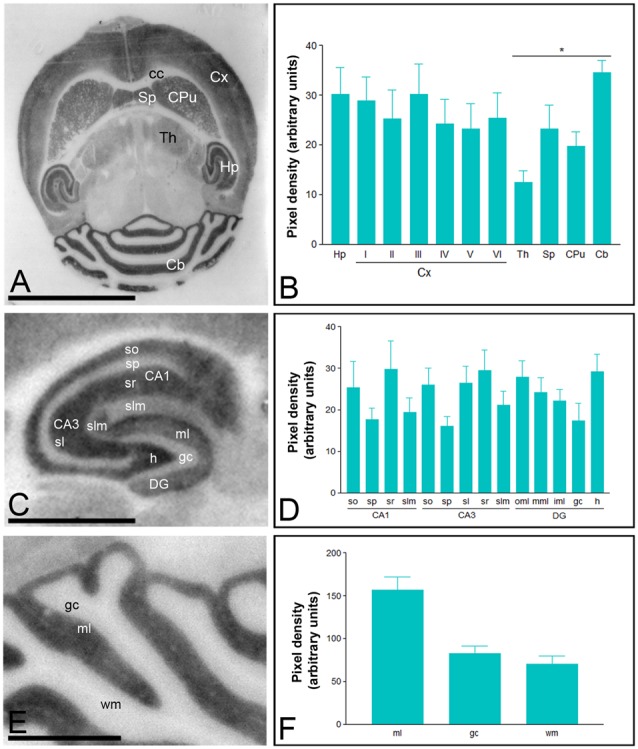
Regional distribution of the T-type Ca2+ channel Cav3.2 subtype in the adult mouse brain. Protein distribution was visualized on histoblots of brain horizontal sections at P90 using affinity-purified anti-Cav3.2 antibodies. The developed histoblots were scanned and densitometric measurements from five independent experiments were averaged together to compare the protein densities. (A,B) The strongest expression was detected in the Cb, Hp, Sp, Cx and CPu, with weaker expression in the Th and no expression in the corpus callosum (cc). In the Cx, the strongest expression levels were found in layer III. (C,D) In the Hp, very strong Cav3.2 immunoreactivity was detected in the strata oriens (so) and radiatum (sr) of the CA1 and CA3 regions, as well as in the hilus and the outer 1/3 of ml of the dentate gyrus (DG). Moderate labeling was observed in the inner 2/3 of ml of the DG, weaker labeling in the stratum lacunosum-moleculare (slm) of the CA1 and CA3 regions. The weakest intensity was observed in the stratum pyramidale (sp) of the CA1 and CA3 regions and the gc of the DG. In the Cb, the strongest expression level was detected in the ml, and weaker in the gc and wm. Error bars indicate SD; *P < 0.05. h, hilus; sl, stratum lucidum. In panels (E,F): gc, granule cell layer; ml, molecular layer; wm, white matter. Scale bars: (A), 0.5 cm; (C,E), 0.1 cm.